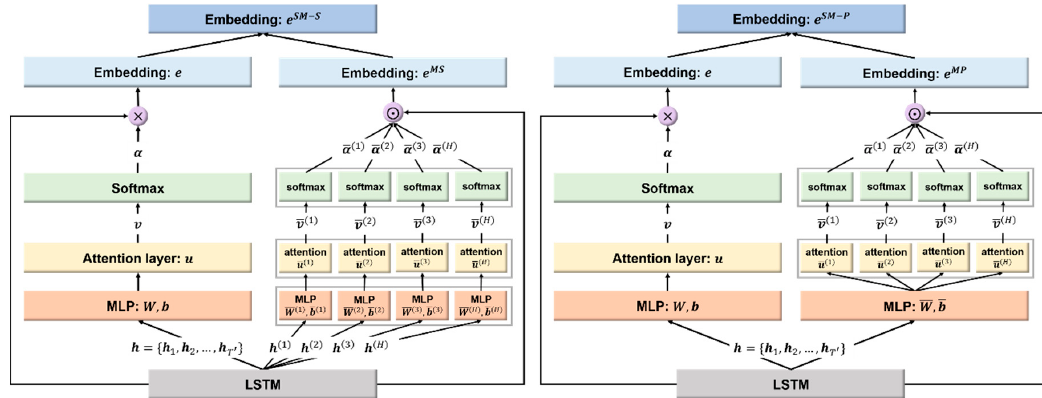
Figure 5. Block diagram of the proposed embedding extractions; e SM − S and e SM − P indicate the embeddings by combination of single-head and split-based multi-head attention ( left ), and combination of single-head and projection-based multi-head attention ( right ) respectively. α ( i ) , v ( i ) , and h denote attention weight, attention layer output, and LSTM output respectively.